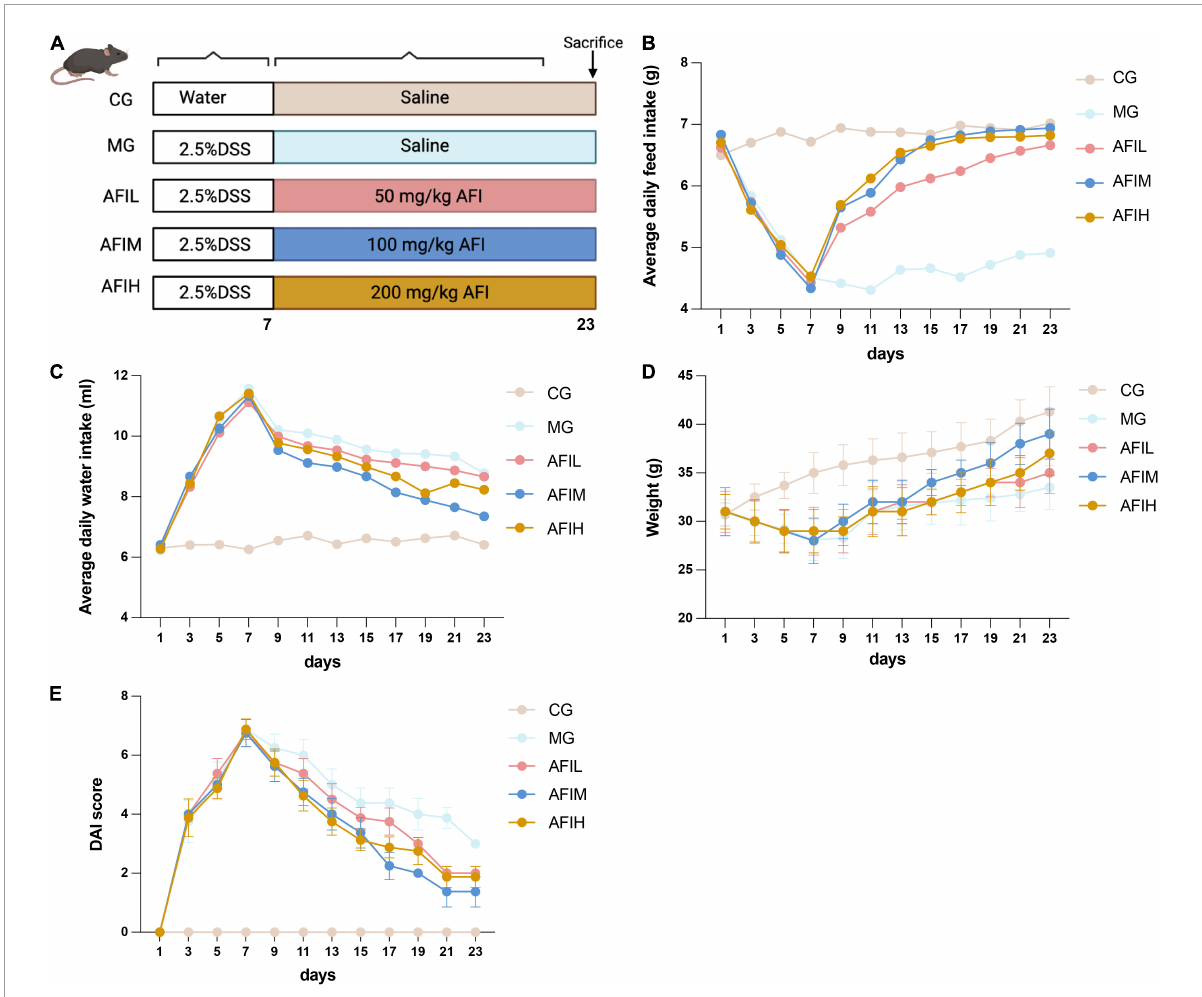
FIGURE1 The effects of AFI on mice. (A) The experimental design, (B) food intake, (C) water intake, (D) body weights and (E) DAI scores for all